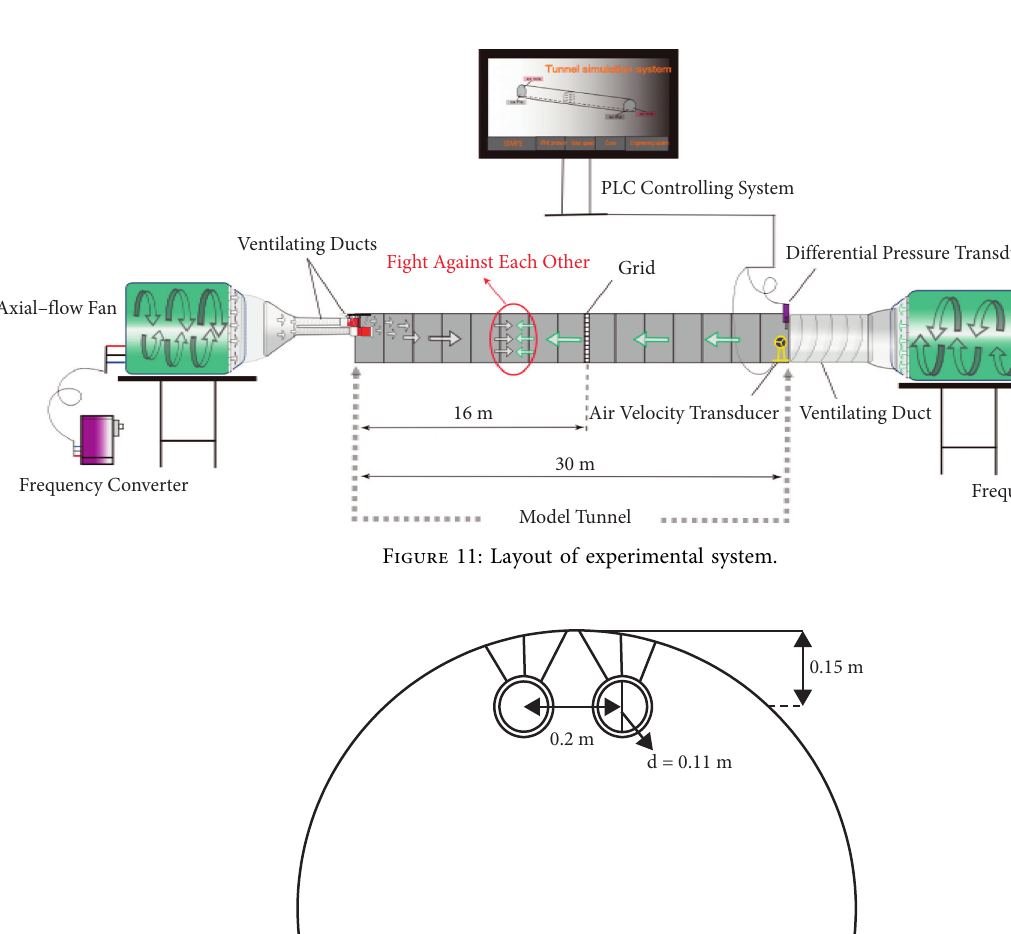
Figure 10: Time required for different lengths of tunnels.